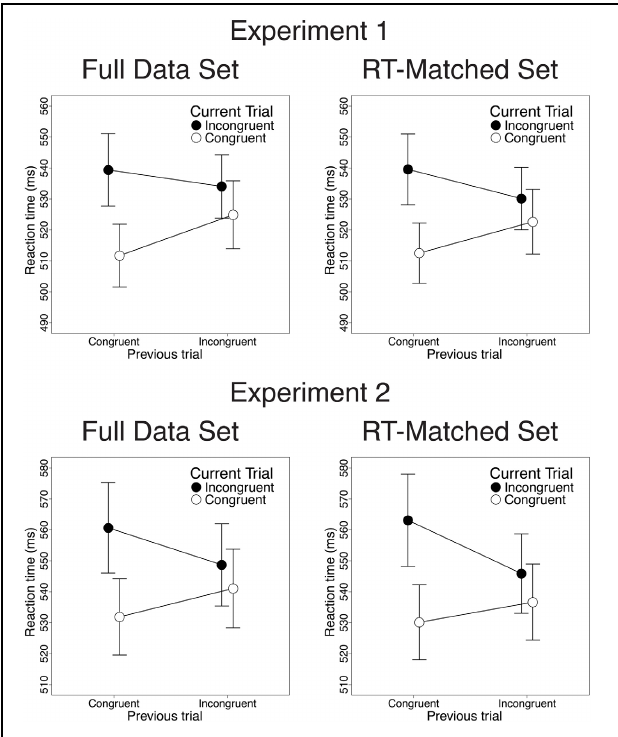
FIGURE 2 | Congruency sequence effects (CSEs) in the RT data. We observed robust CSEs in the full data set [Experiment 1: t ( 22 ) = 3 . 82, p < 0 . 001; Experiment 2: t ( 25 ) = 5 . 32, p < 0 . 001] and in the RT-matched data set [Experiment 1: t ( 22 ) = 4 . 34, p < 0 . 001; Experiment 2: t ( 25 ) = 5 .